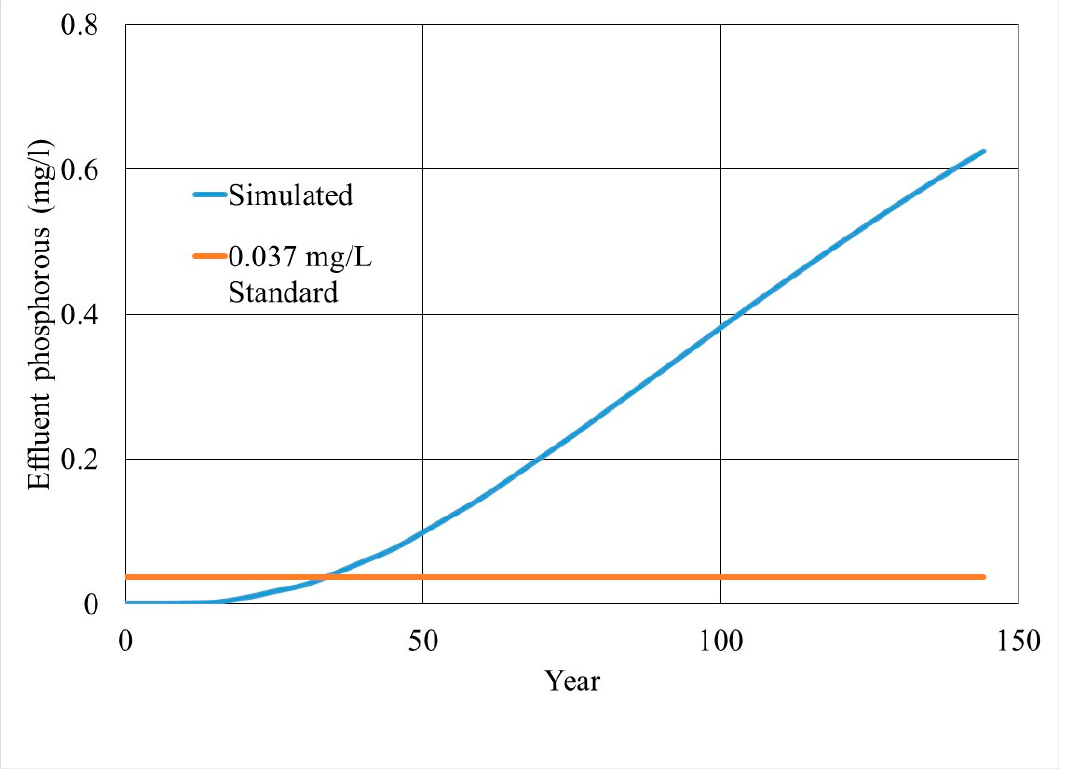
Figure 9. Mean effluent concentrations from 20 simulations in 3-D model, for six sand plug cell with influent concentration of 1 mg/L [41].